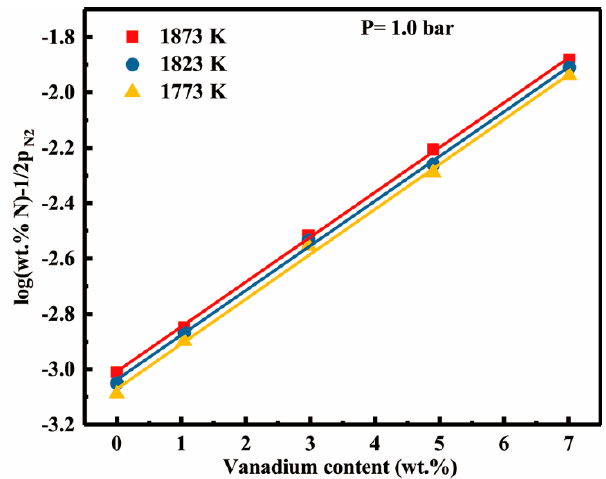
Figure 8. log ( wt pct N ) − 1/2log p N vs. the vanadium content in binary Ni-V alloys at different log( ) 1/ 2log wt pct N p − vs. the vanadium content in binary Ni-V alloys at different Figure 8. 2 N 2 temperatures.